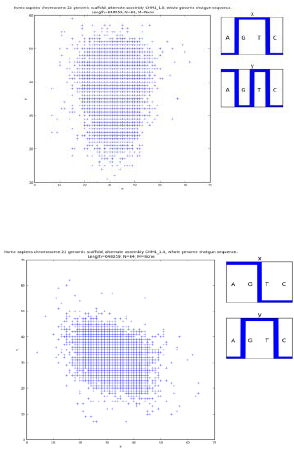
Fig. 5. Illustration of an integrated two-dimensional representation of the nucleotide composition of Homo Sapiens chromosome 22 on one of the visualization planes. A pair of Walsh functions used for parameterization is displayed on the right. The axes of abscissas and ordinates correspond to the number of units of each 64-plet using a pair of binary oppositional